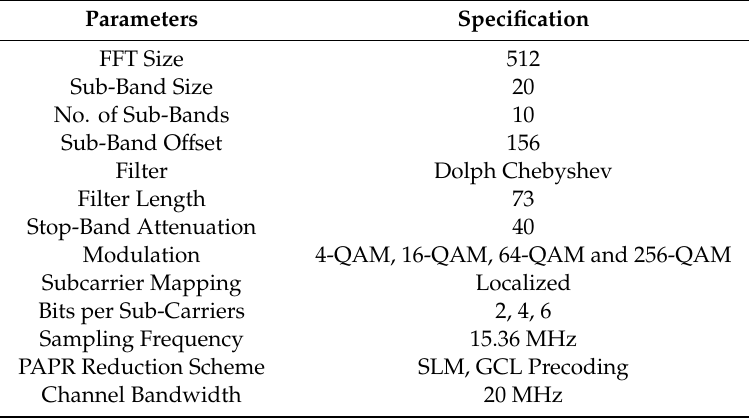
Table 1. Simulation